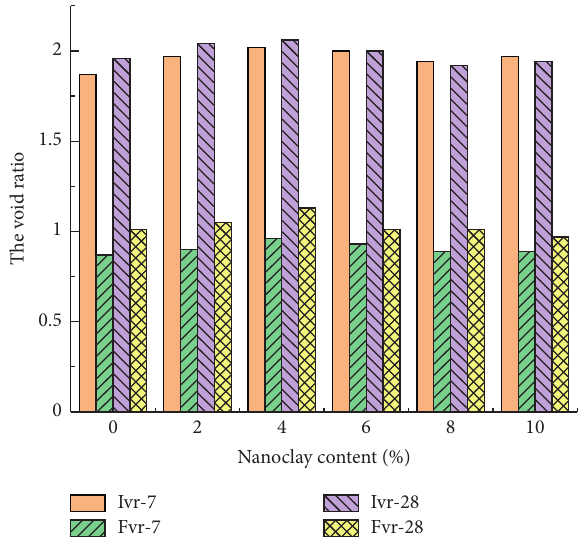
Figure 11: Change in the void ratio of